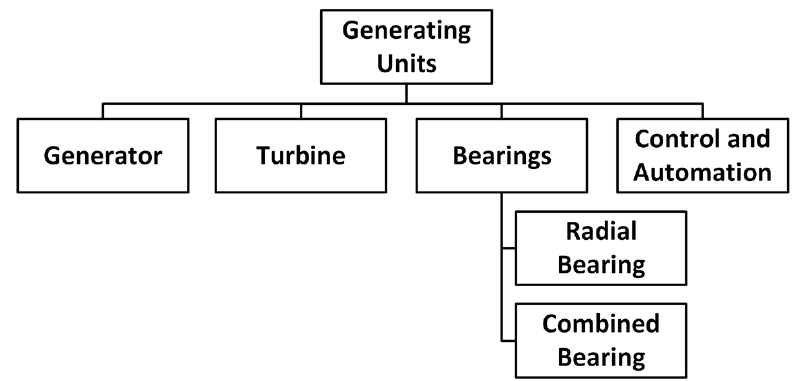
Figure 4. Generating units’ functional tree.